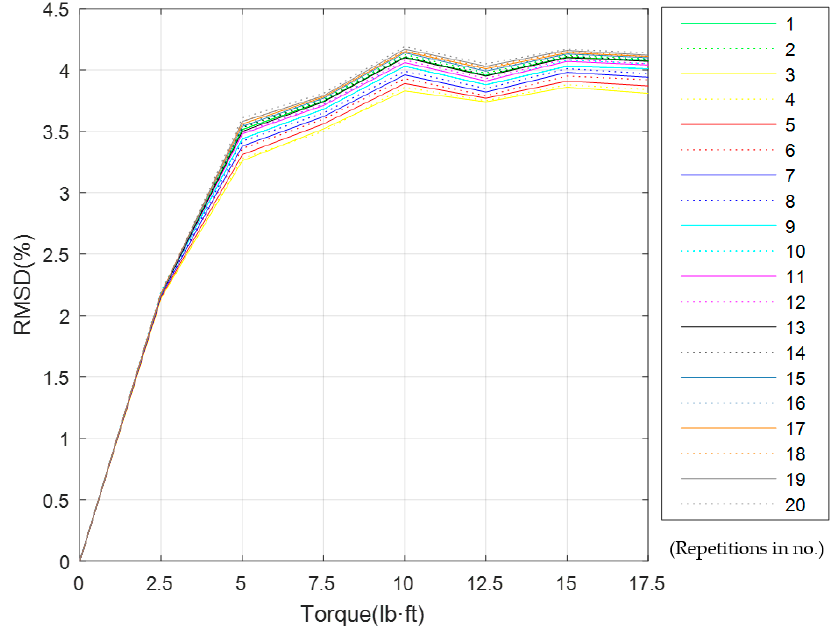
Figure 12. The RMSD looseness index for twenty repeated experiments at different torque levels.